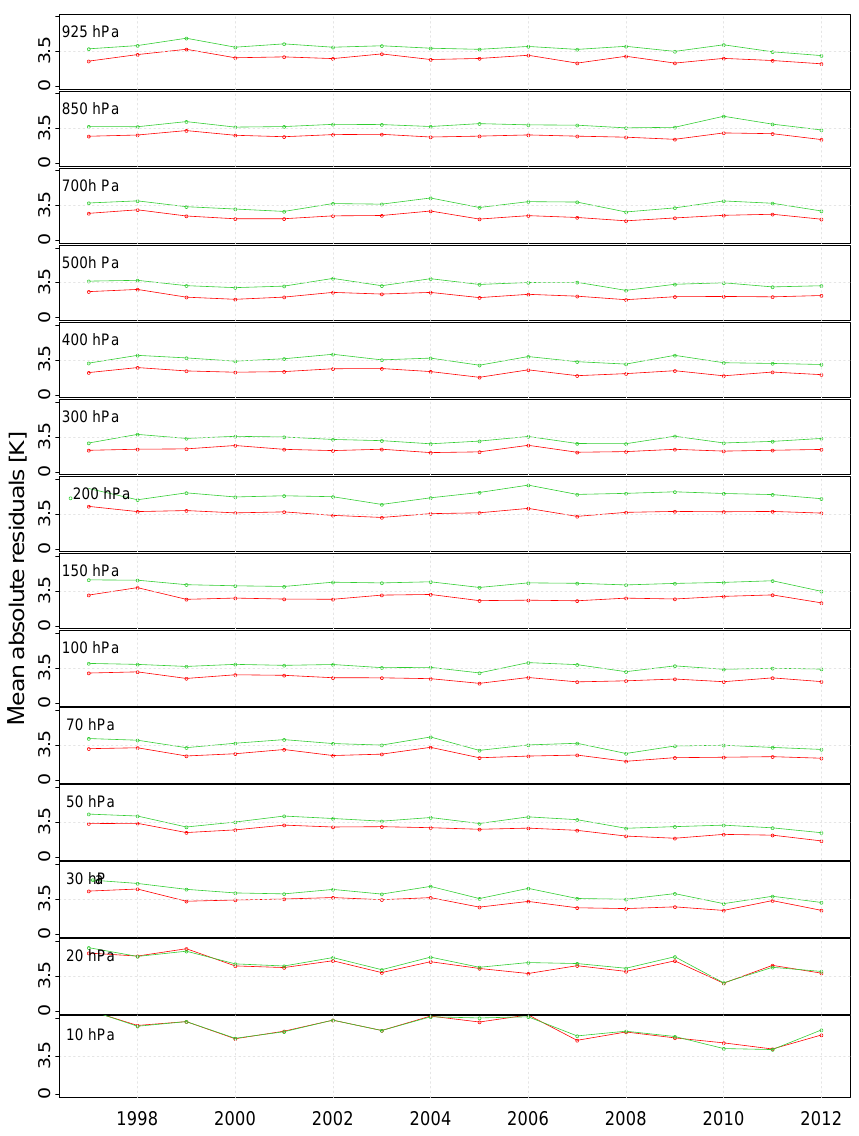
Figure 10. Yearly mean of absolute residuals between the Lauder radiosonde measurements and both (i) the diurnal cycle (green) and (ii) the denial study